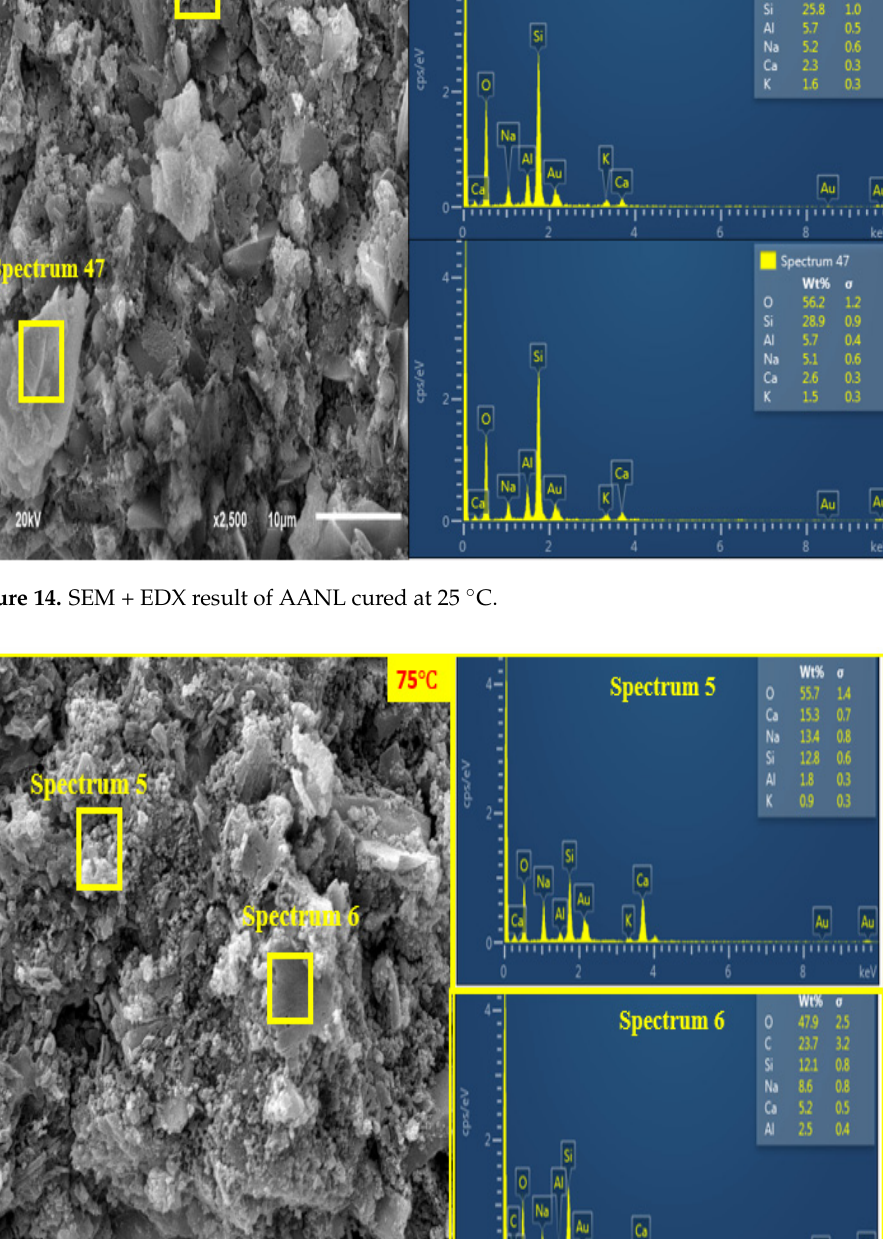
Figure 16. SEM + EDX of AANL cured at 9 0 ℃.